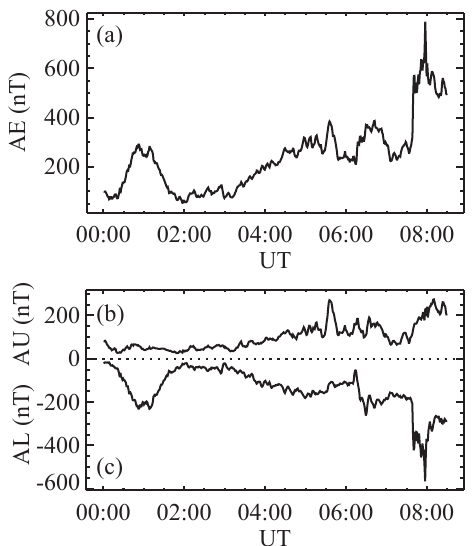
Figure 9. AE (a) , AU (b) and AL (c) indices recorded on 26 Jan- uary 2001. After 04:00UT, the AE index has a value larger than 200nT, compatible with SMC conditions.